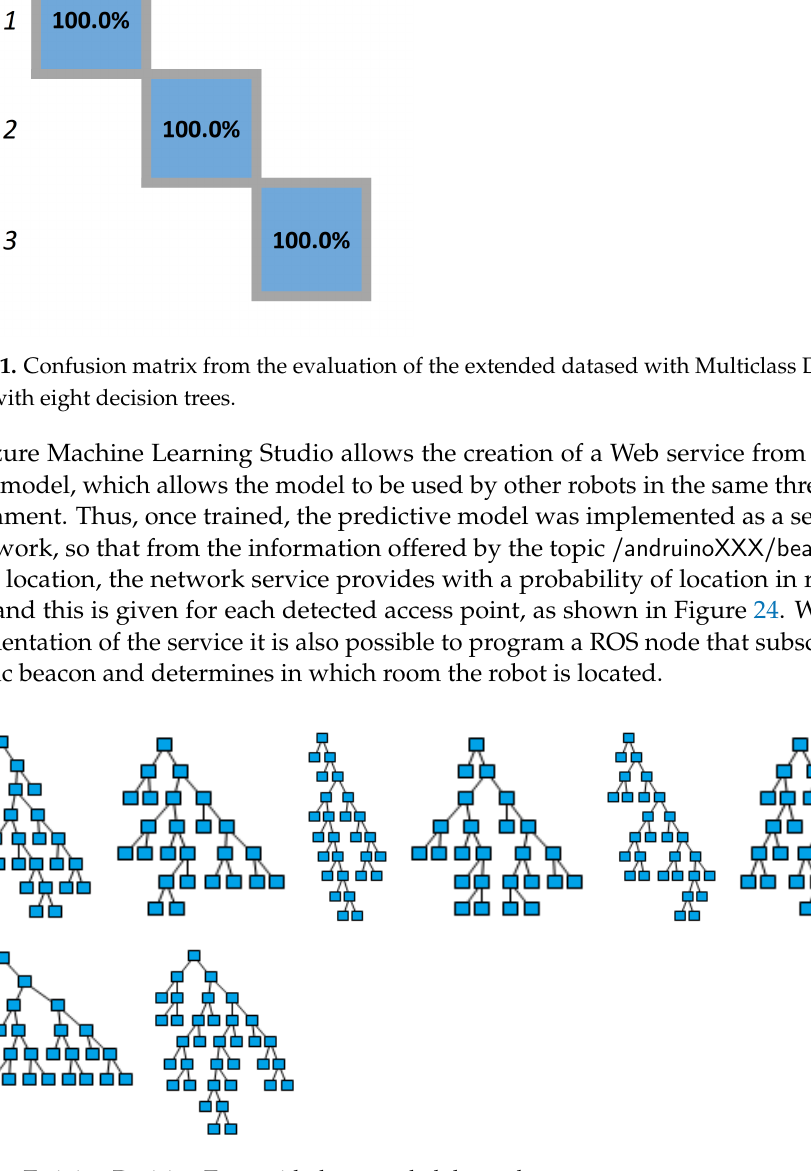
Figure 22. Training Decision Trees with the extended